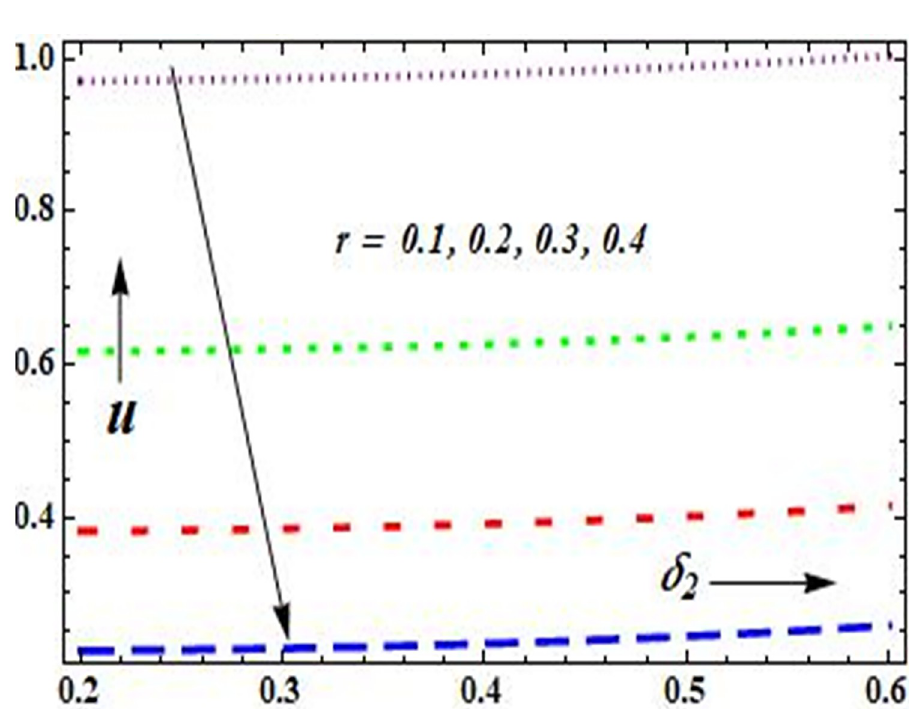
Fig 25. Plot of u on r & δ 2 with ϕ ¼ π